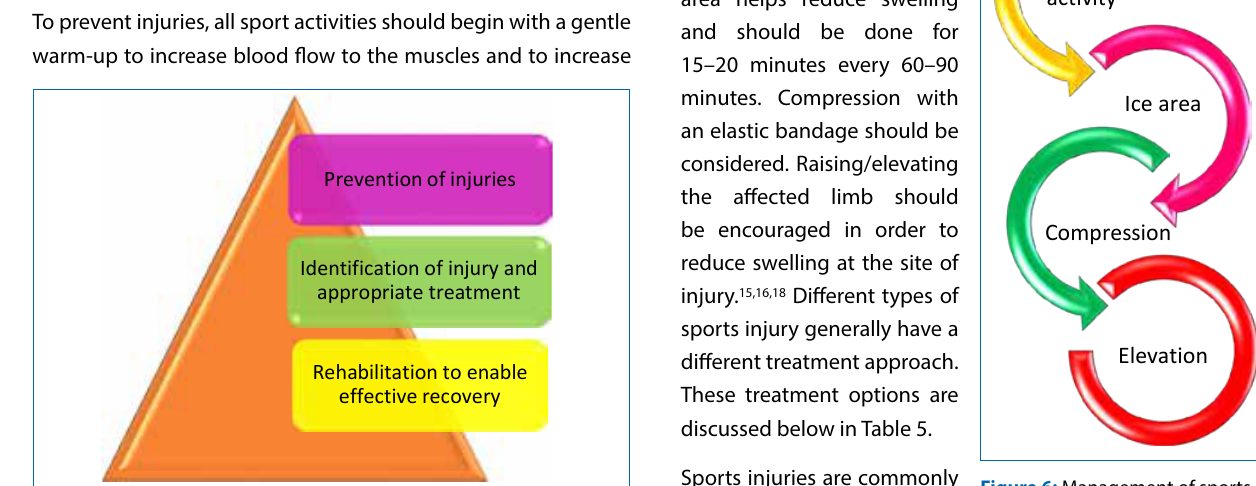
Figure 6: Management of sports injuries using the PRICE principle